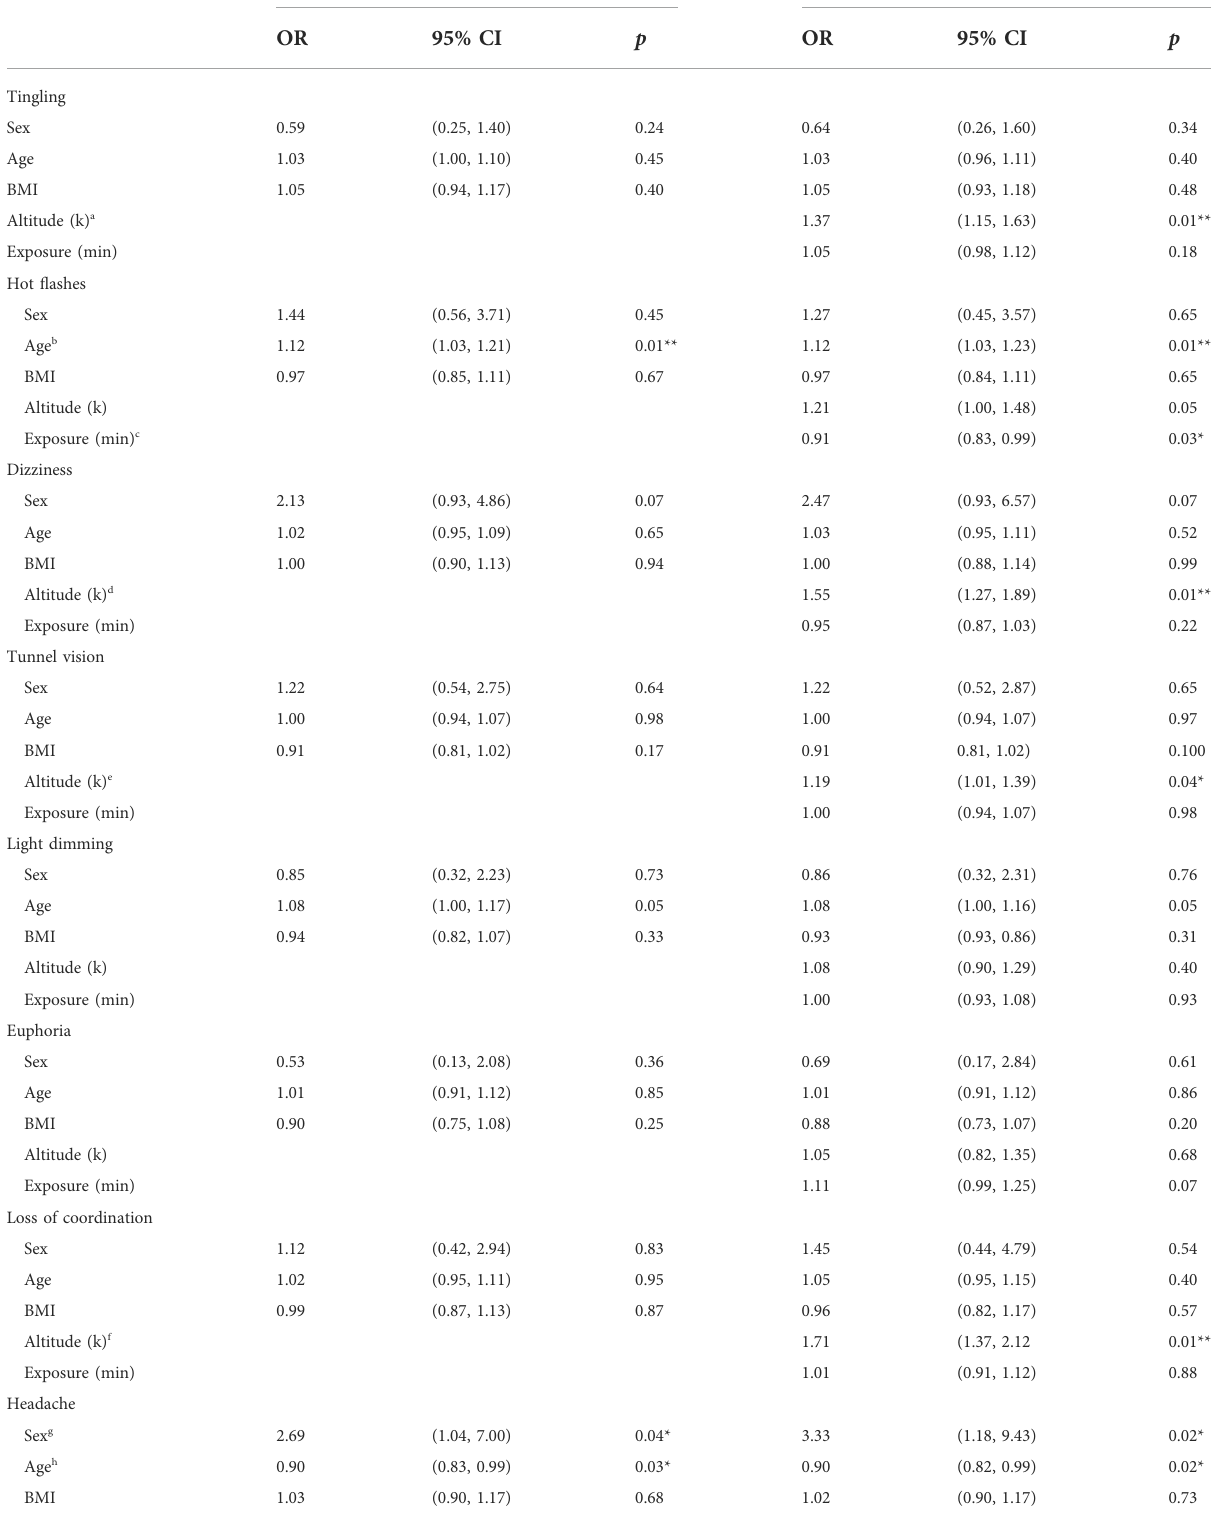
TABLE 4 Binary logistic regression models of individual self-reported hypoxia-related